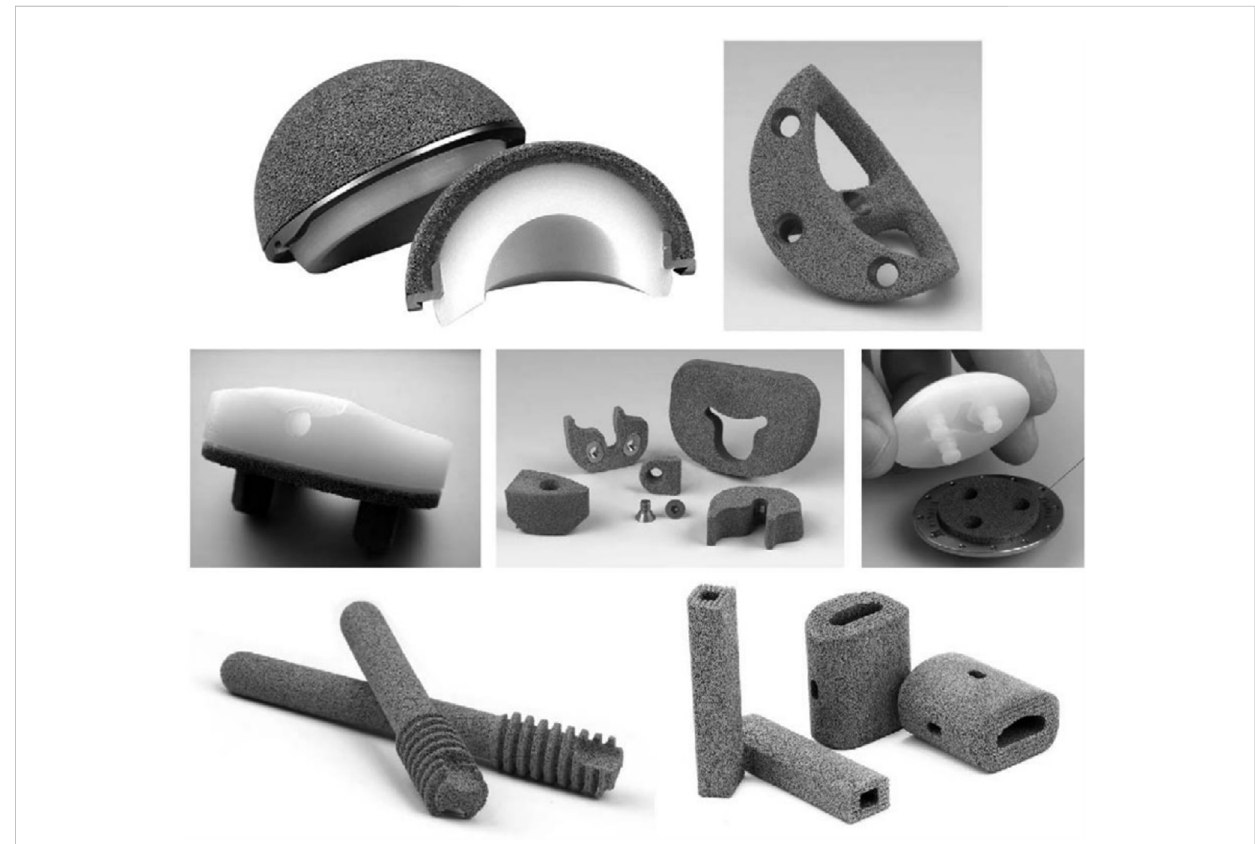
Multipleorthopedicapplicationsforporoustantalum.Toprow:monoblockacetabulumandarevisionacetabularaugment.Middlerow:monoblock tibia, revision total knee arthroplasty augments, and salvage patella button. Bottom row: osteonecrosis implant and spine arthrodesis implants (Courtesy of Zimmer, Warsaw, IN) (Russell Levine et al., 2006). Copyright ©2006 Published by Elsevier